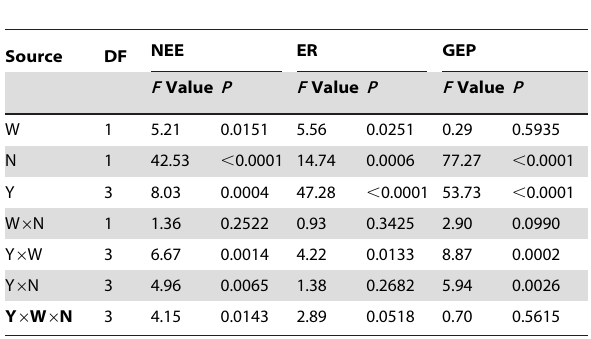
Table 1. DF, F values and P values from three-way ANOVA on the effects of warming (W), nitrogen (N), and year (Y), and their interactions on net ecosystem CO 2 exchange (NEE), ecosystem respiration (ER) and gross ecosystem productivity